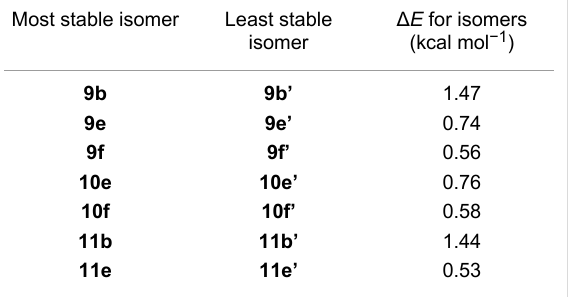
Table 8: Energies for isomeric products obtained from DFT-B3LYP calculations. Most stable